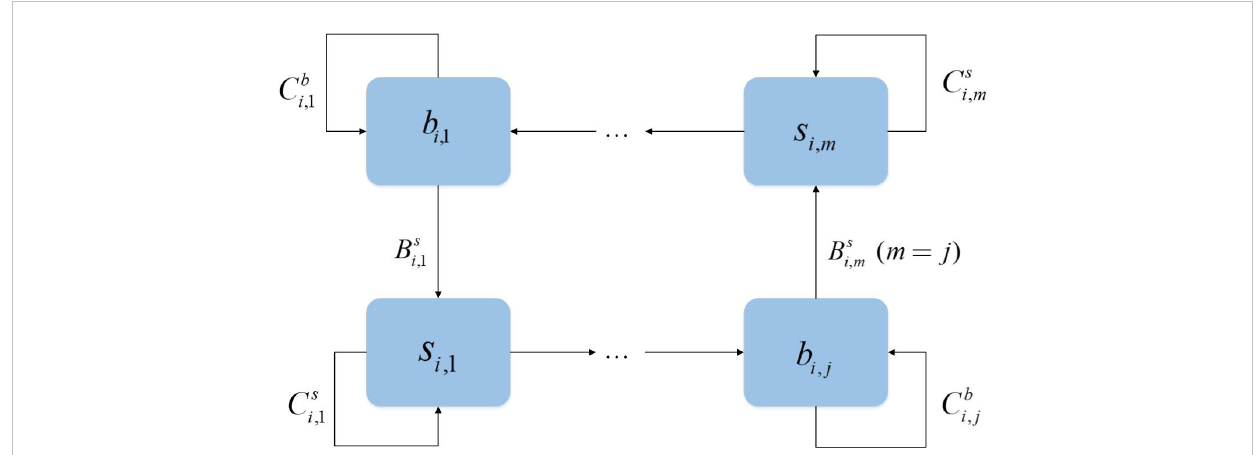
FIGURE 1 FSM module of liner shipping